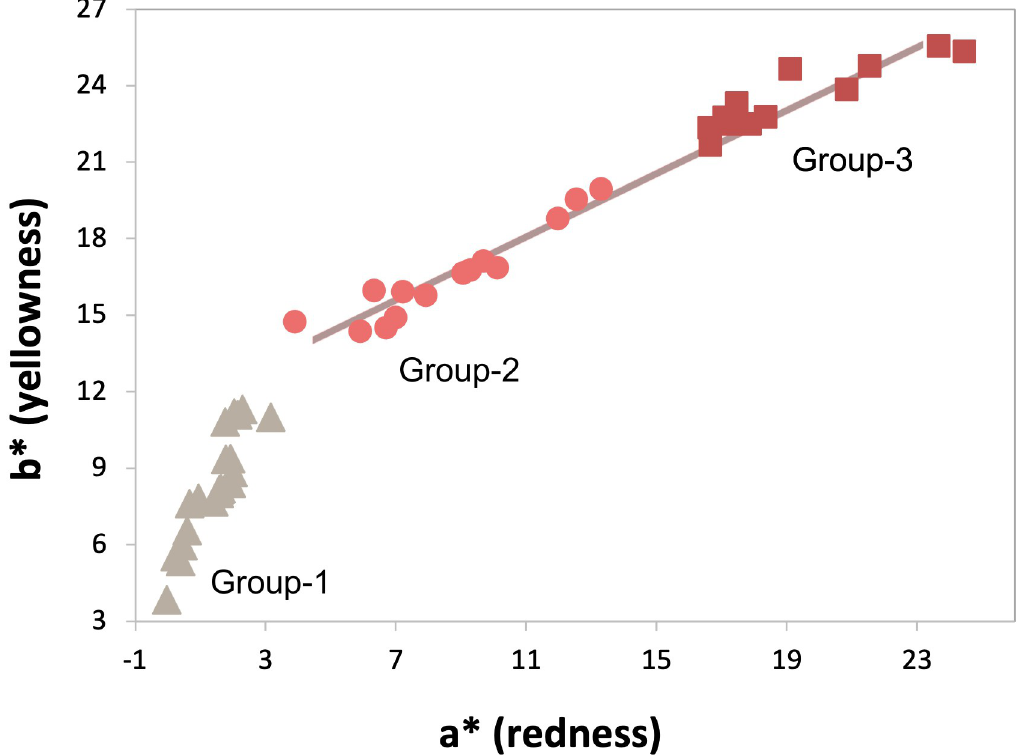
Fig 6. Scatter plot of a � (more/less red) and b � (more/less yellow) parameters in all the samples analyzed, the three groups according to color parameters are identified. Note that group-2 and -3 samples are in the same mixing line (grey line). https://doi.org/10.1371/journal.pone.0274849.g006 (16:0) and stearic acid (18:0). The greasy soil samples 795 and 836, that contained the largest number of avian barbules and mammalian hairs, were separated in PCA (PC1 describing 75%, PC2 12%, and PC3 9% of total data variation) and on the consequent heat map from the other samples (numbers 233, 450, 796 and 841) by containing larger mol% of unsaturated FAs (oleic acid 18:1n-9, and linoleic acid 18:2n-6) and long chain SFAs (20:0, 22:0 and 24:0) (See Fig 1 in S3 Appendix). In addition, the different relative concentrations of several minor FA compo- nents increased the chemical variability among the samples.